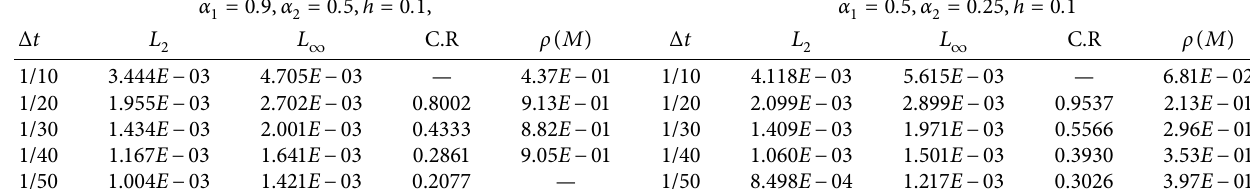
Table 3: Errors norm of Y at diferent step sizes.